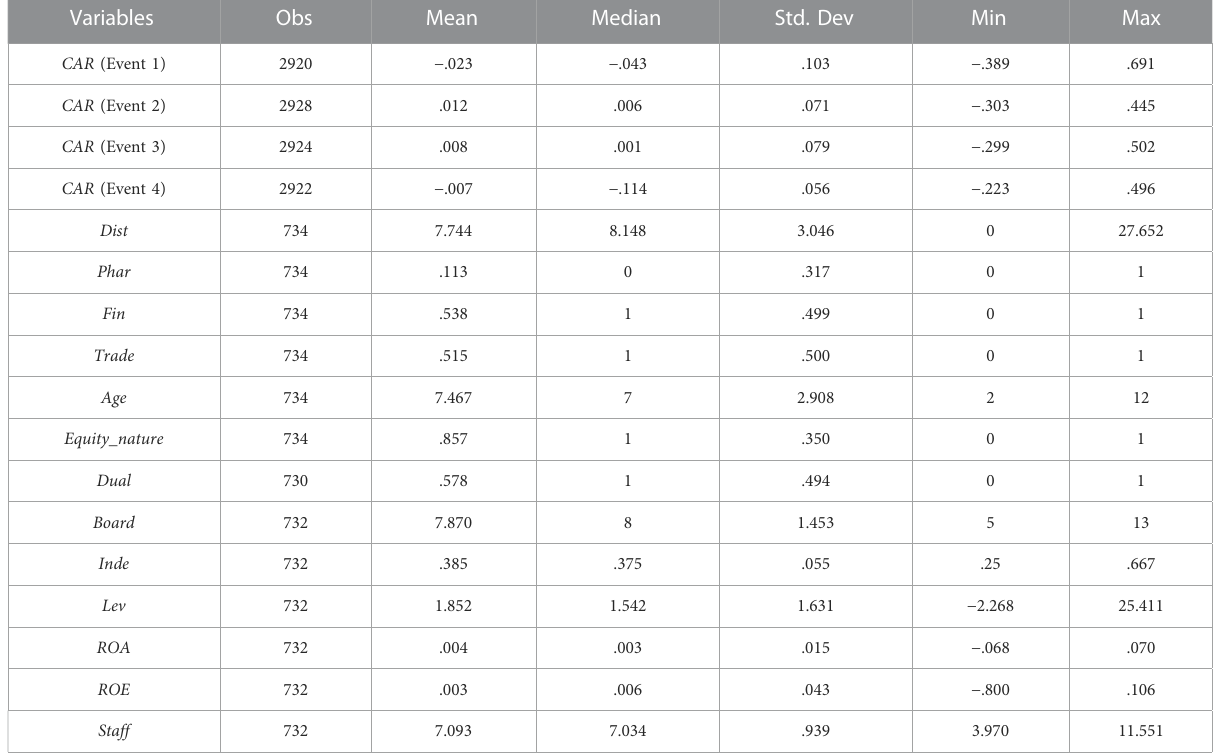
TABLE 6 Descriptive statistics.